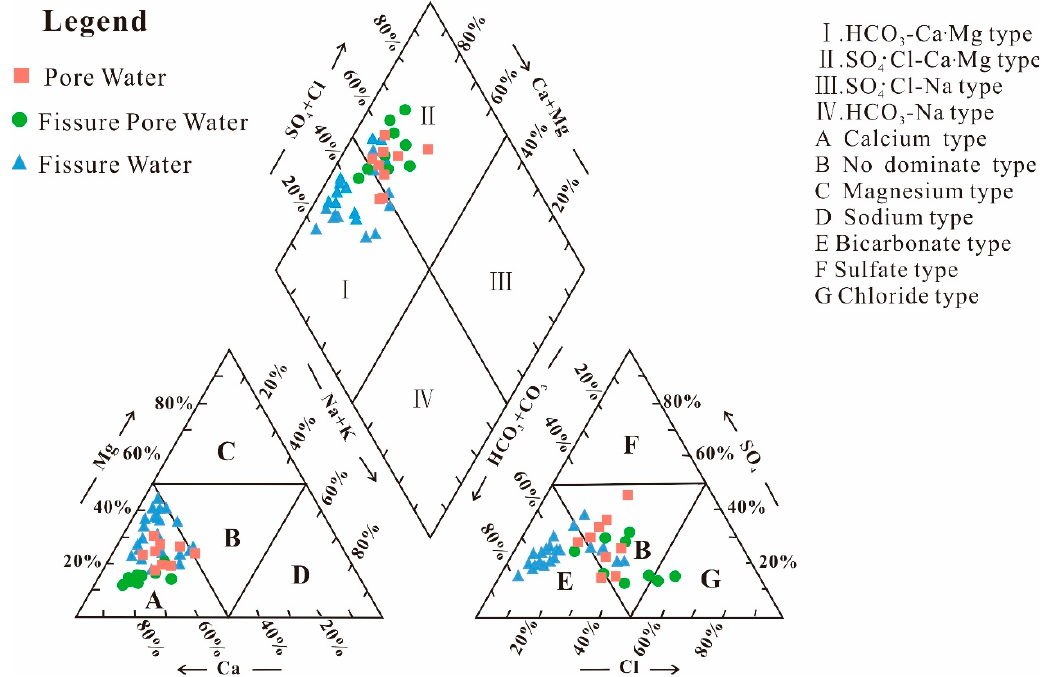
Figure 3. Piper diagram showing the hydrochemical characteristics of groundwater in the Wulian area.